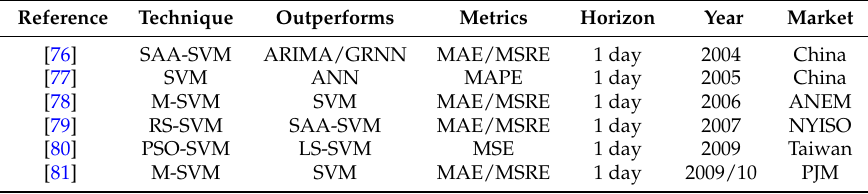
Table 4. Summary on support vector machine (SVM) for electricity